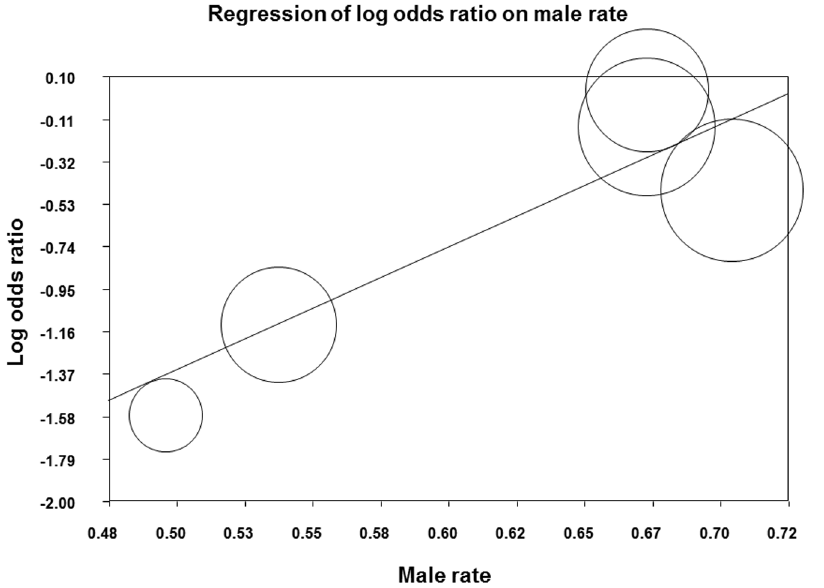
Figure 5. Meta-regression plot for log odds ratios in rates of patients with severe hepatic steatosis by proportion of males (%) in rs8099917.